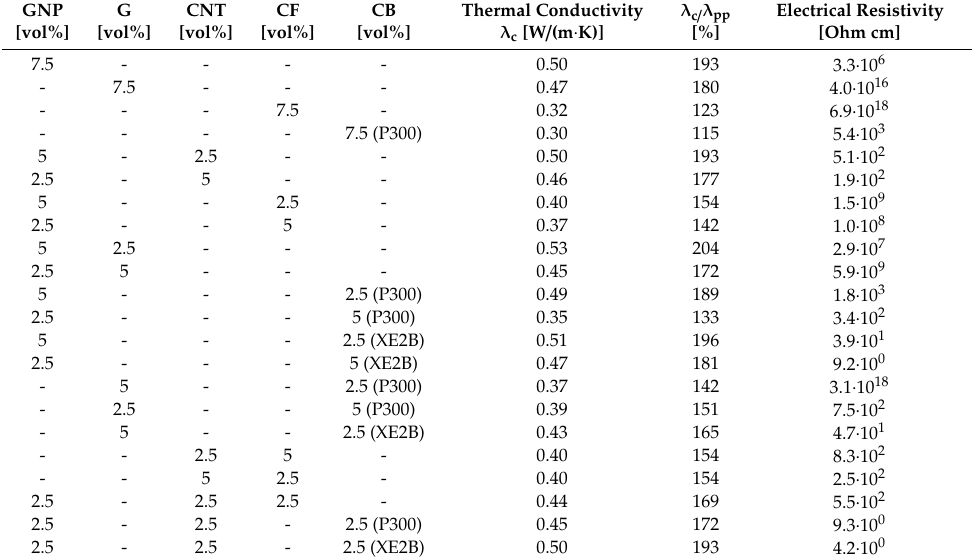
Table 3. Thermal conductivity and electrical volume resistivity of PP composites containing 7.5 vol% carbon-based fillers (as Graphite KS500 was used), λ pp = 0.26 W / (m · K). CB: carbon black, G: